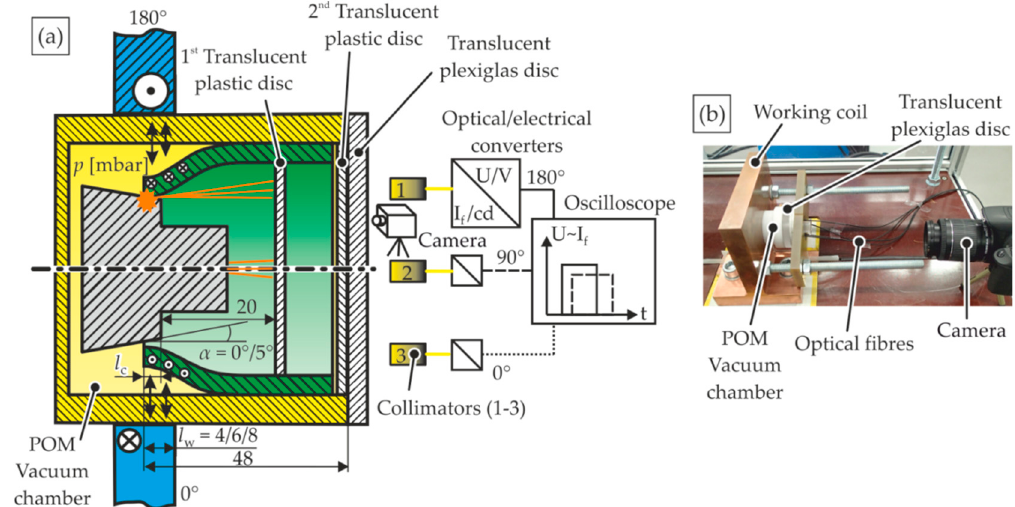
Figure 3. Modified setup for MPW at different surrounding pressures p with collimators (1–3) for flash detection and camera ( a ) schematic (not true to scale) and ( b ) photograph (position of all parts is fixed during MPW).